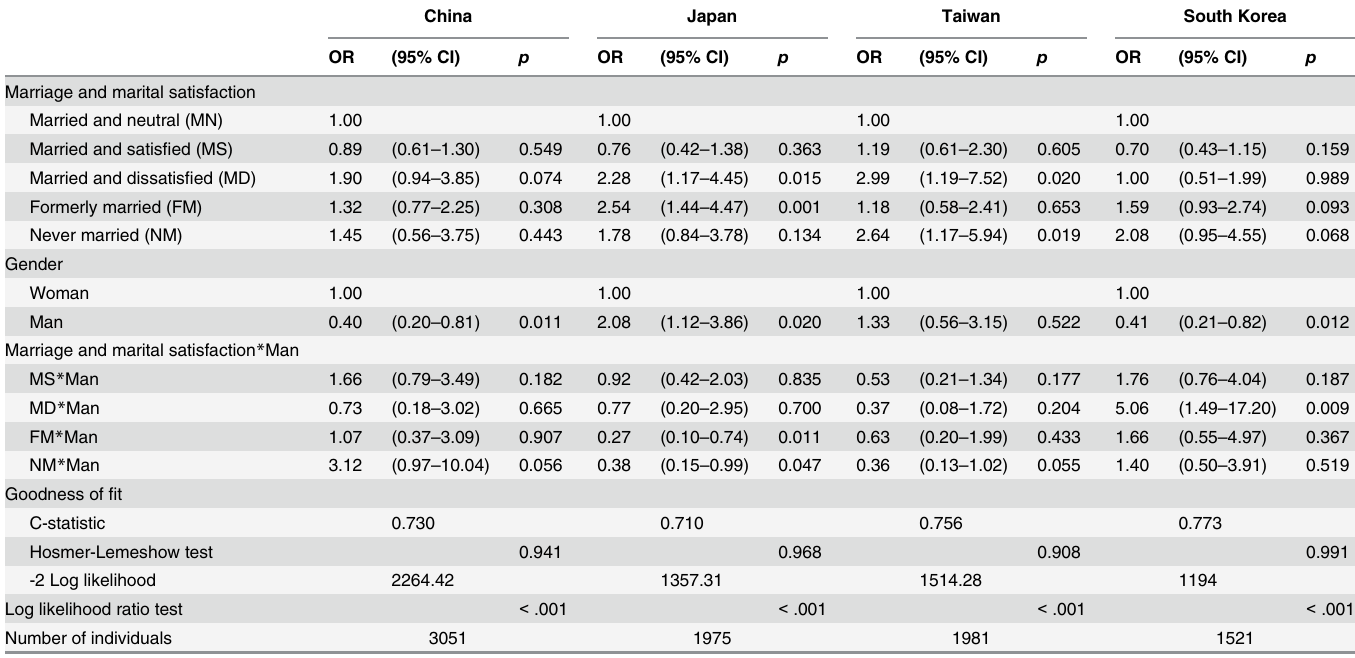
Table 2. Fully adjusted associations between two variables (marriage and marital satisfaction; gender) and reported poor health by country, the 2006 East Asian Social Survey. China Japan Taiwan South